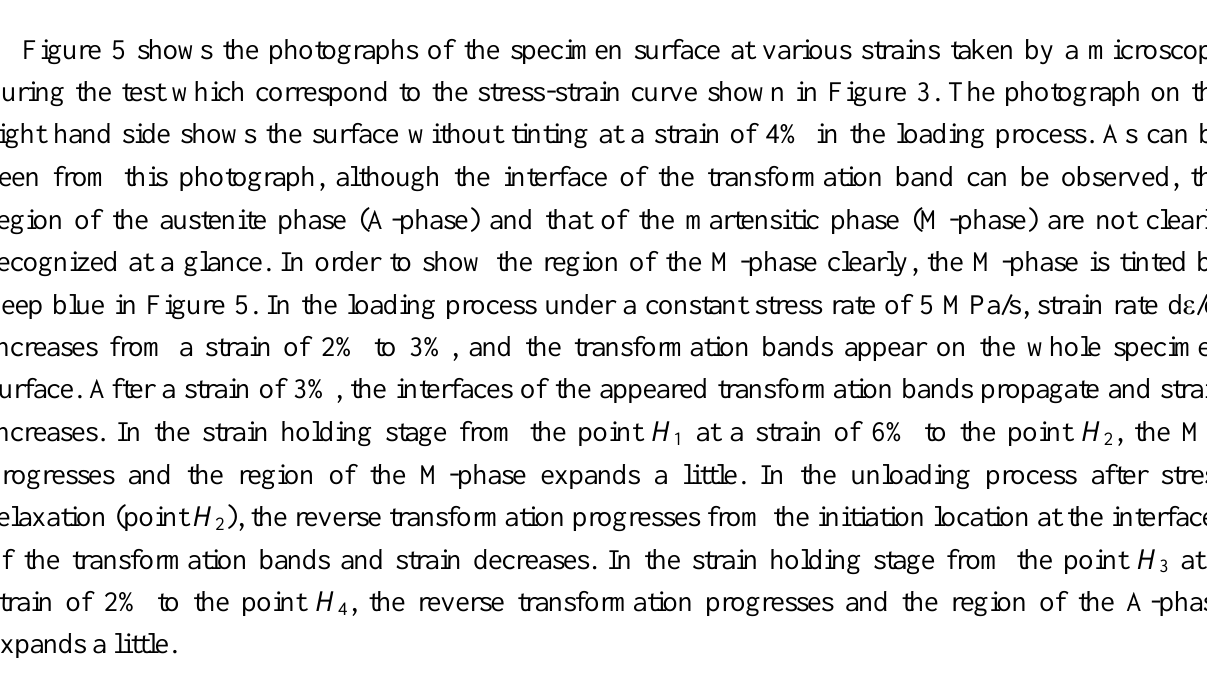
(ε = 6%) during loading and at a 1 1